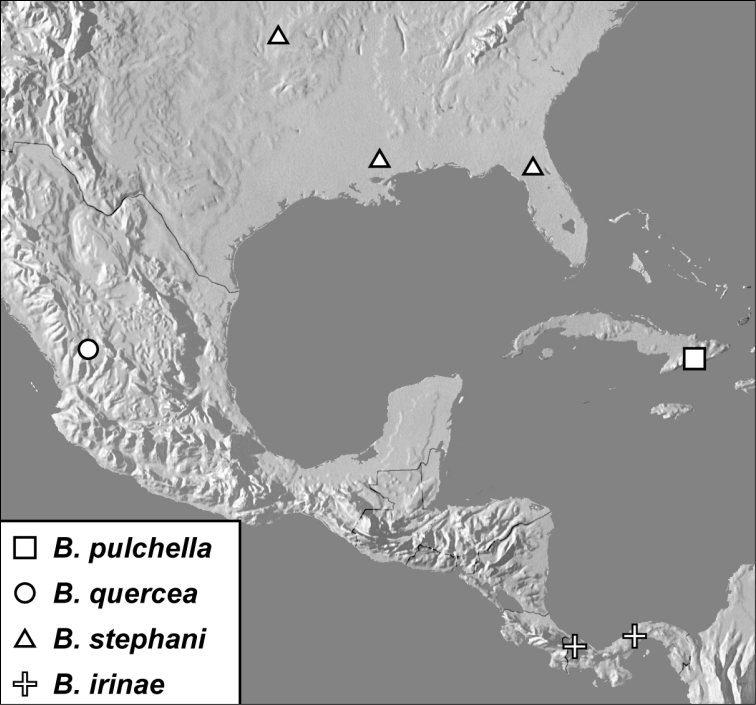
Baconia aeneomicans group records.